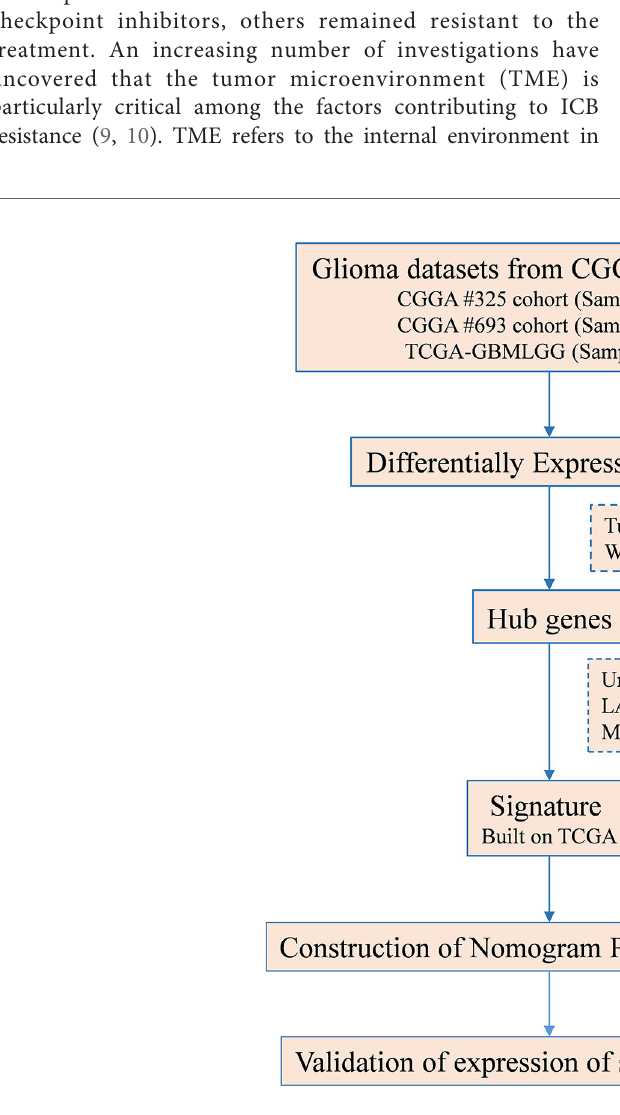
FIGURE 1 | Flowchart of this study. TCGA, The Cancer Genome Atlas; CGGA, Chinese Glioma Genome